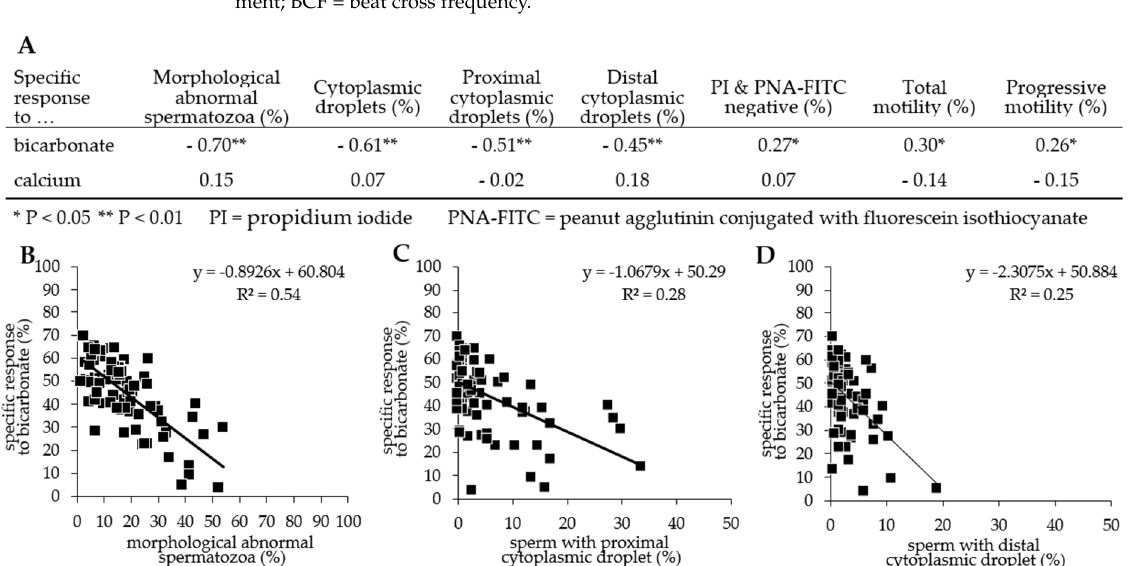
Figure 1. Correlation between semen parameters. ( A ) Spearman rank correlation coefficients for selected sperm parameters measured after 24 h storage at 17 ◦ C (n = 78 boars). The specific response to bicarbonate inversely correlated with ( B ) the percentage of morphological abnormal spermatozoa, ( C ) the percentage of spermatozoa with proximal cytoplasmic droplets, and ( D ) the percentage of spermatozoa with a distal cytoplasmic droplet.